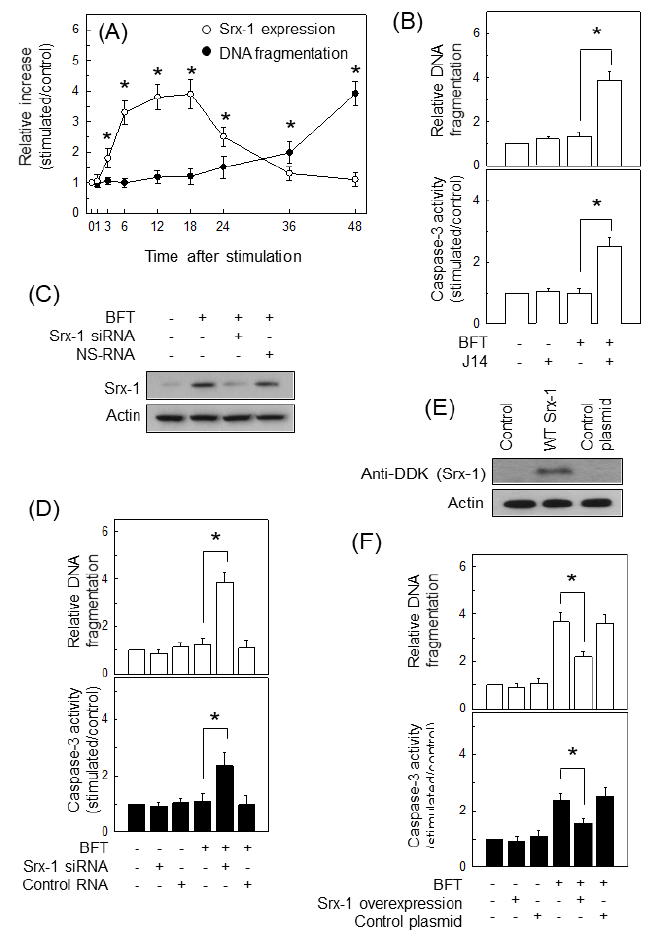
Figure 8. Relationship between Srx-1 expression and apoptosis. ( A ) After adding BFT (500 ng / mL) to CCD 841 CoN cells, DNA fragmentation and Srx-1 expression were measured at the indicated periods of time using each ELISA kit. Data were obtained through five independent experiments and expressed as mean increase relative to unstimulated controls ± SEM. The asterisk indicates that the p -value is less than 0.05; ( B ) CCD 841 CoN cells were combined with J14 (25 µ M) for 18 h. BFT (500 ng / mL) was then added to each group for 12 h. DNA fragmentation and caspase-3 activity were measured by ELISA. Quantitative data analyses were performed with five independent experiments and expressed as mean increase relative to unstimulated controls ± SEM. The asterisk indicates that the p -value is less than 0.05; ( C ) HCT 116 cells were transfected with siRNA against Srx-1 or NS-RNA. BFT (500 ng / mL) was added to each group for 18 h. Protein expression was assessed by western blot; ( D ) Transfection was identical to ( C ). BFT (500 ng / mL) was added to each group for 12 h. Measuring DNA fragmentation and caspase-3 activity were identical to ( B ). Data were obtained through five independent experiments and expressed as mean increase relative to unstimulated controls ± SEM. The asterisk indicates that the p -value is less than 0.05; ( E ) Wild type (WT)-Srx-1-overexpressing plasmids were introduced into HCT 116 cells using a lentiviral system. The protein expression of Srx-1 was evaluated by western blot. All images in ( C ) and ( E ) are representative of more than three independent experiments; ( F ) Transfection was identical to ( E ). BFT (500 ng / mL) was added to each group for 48 h. Measuring DNA fragmentation and caspase-3 activity were identical to ( B ). Data were obtained through five independent experiments and expressed as mean increase relative to unstimulated controls ± SEM. The asterisk indicates that the p -value is less than 0.05.